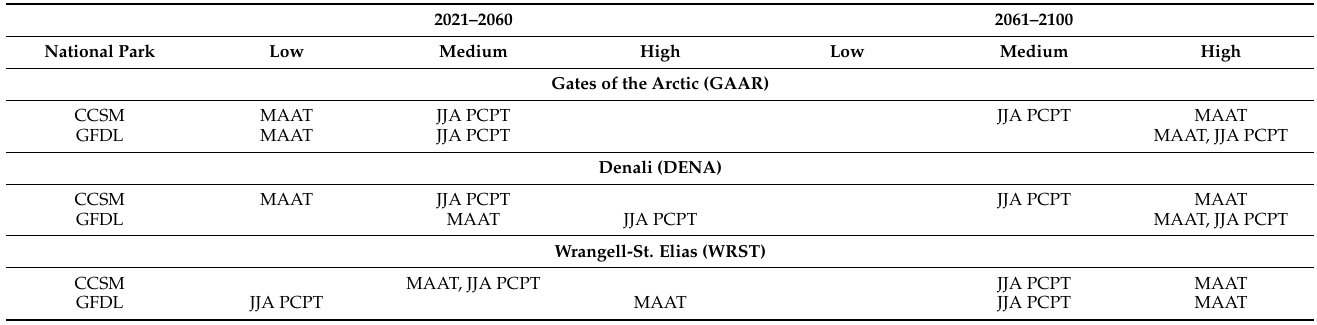
Table 4. Risk level matrix for the bias-corrected CCSM and GFDL mid-century (2021–2060, left) and late-century (2061–2100, right) projections of mean annual air temperature (MAAT; ◦ C) and summer precipitation (JJA PCPT; cm) for the road corridors in the three Alaska national parks. High means that the projected upper quartile value was above 0 ◦ C for MAAT, and above the historical R40 value for JJA PCPT; medium means that the projected maximum MAAT exceeded 0 ◦ C, and exceeded the historical R40 for JJA PCPT; finally, low means that the projected maxima were below freezing for MAAT and below the historical R40 for JJA